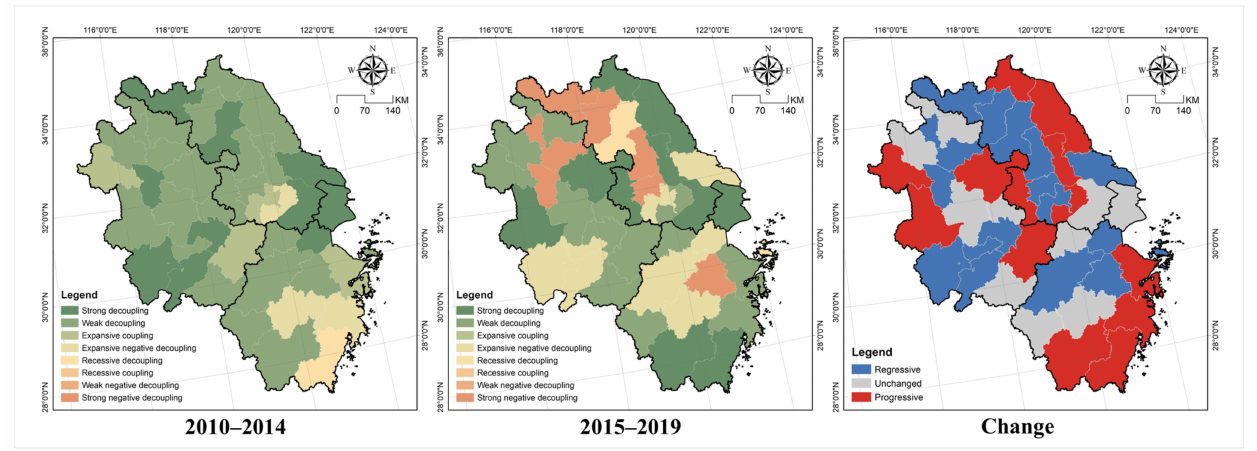
Figure 11. Spatial analysis of the decoupling relationship between urban industrial land and enter- prise assets in Yangtze River